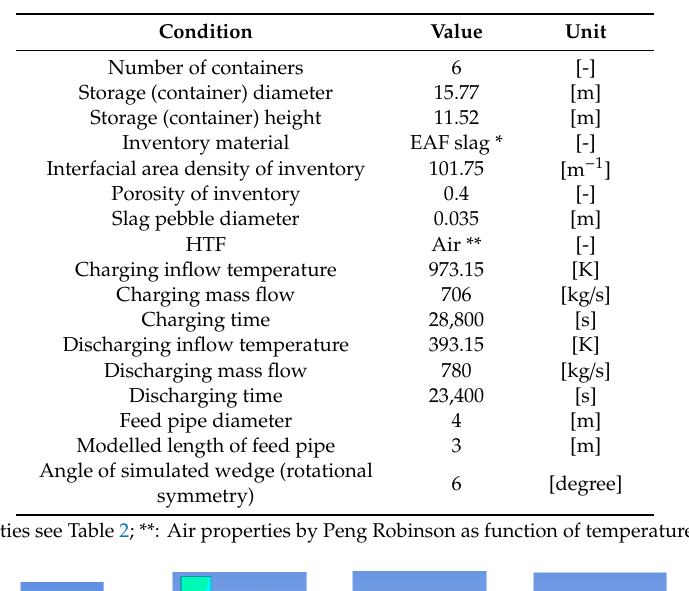
Table 5. General boundary conditions for computational fluid dynamics (CFD) calculations.